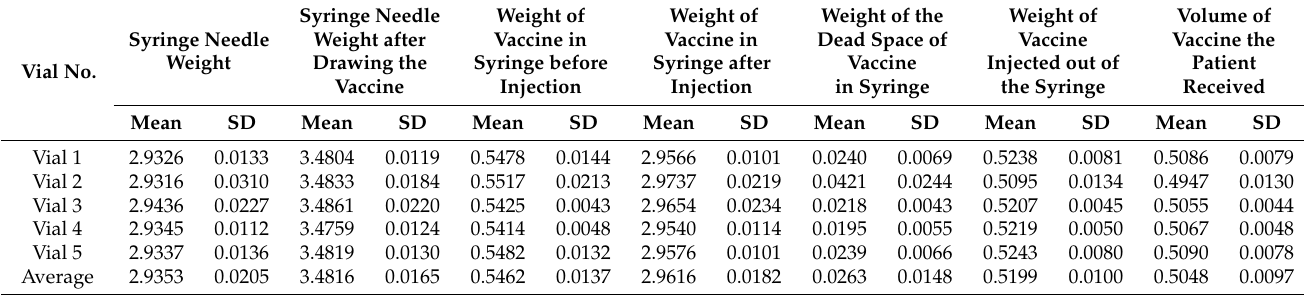
Table 2. The second stage using ChAdox1-n CoV in the real